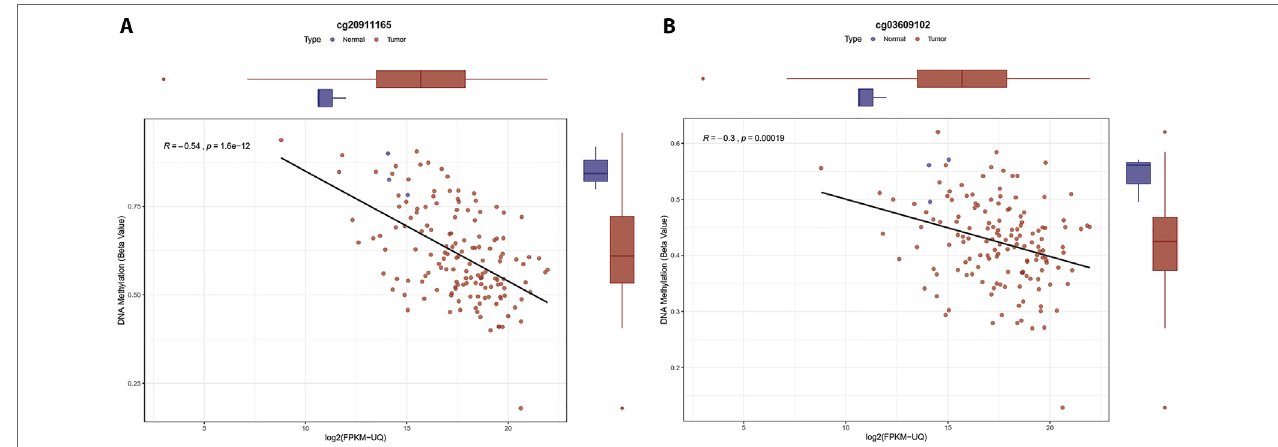
FIGURE 4 | Correlation plot for the MUC5B promoter methylation sites. Boxplot for gene expression and DNA methylation on top and right side respectively, tumor samples are in red and normal samples in blue color. (A) Correlation plot and boxplot for cg20911165. (B) Correlation plot and boxplot for cg03609102.